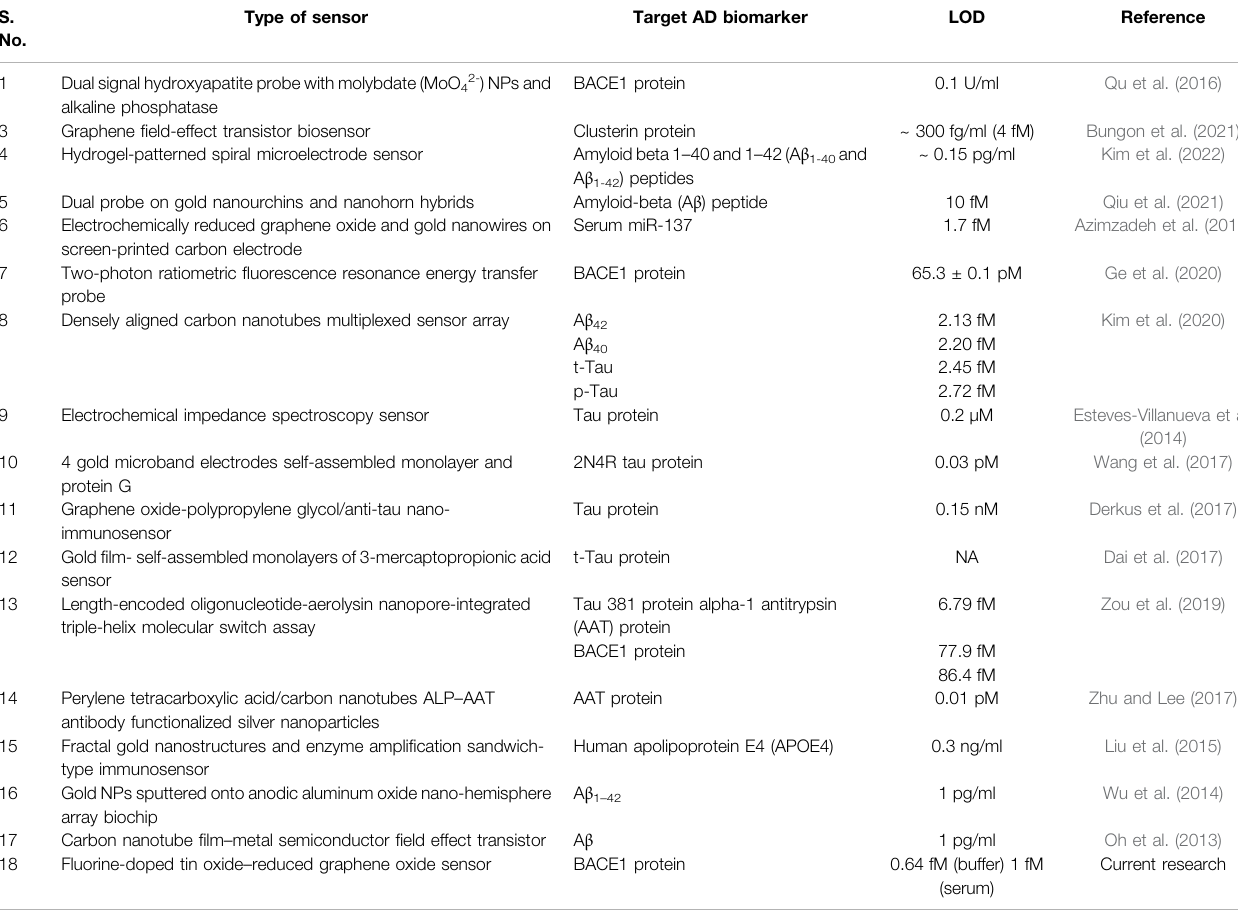
TABLE 1 | Comparative data on various electrochemical sensors developed for AD diagnosis for different biomarkers. S. No.